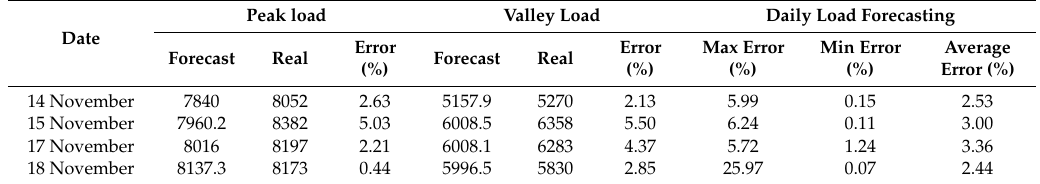
Table 10. The Summary of the forecasts for 14, 15, 17 and 18 November.